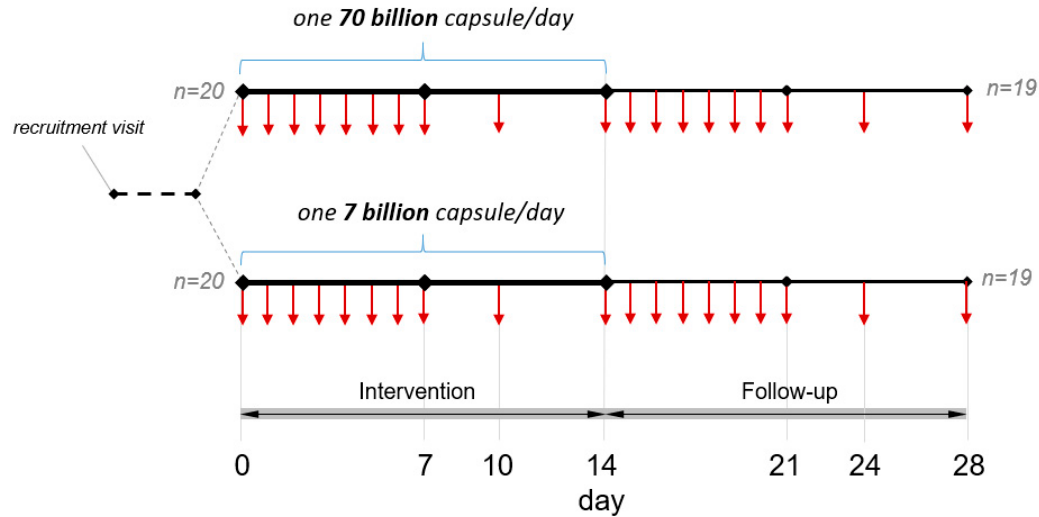
Figure 1. Schematic of the study design. Vertical arrows indicate the days of fecal sample collection (when defecation occurred) from volunteers.